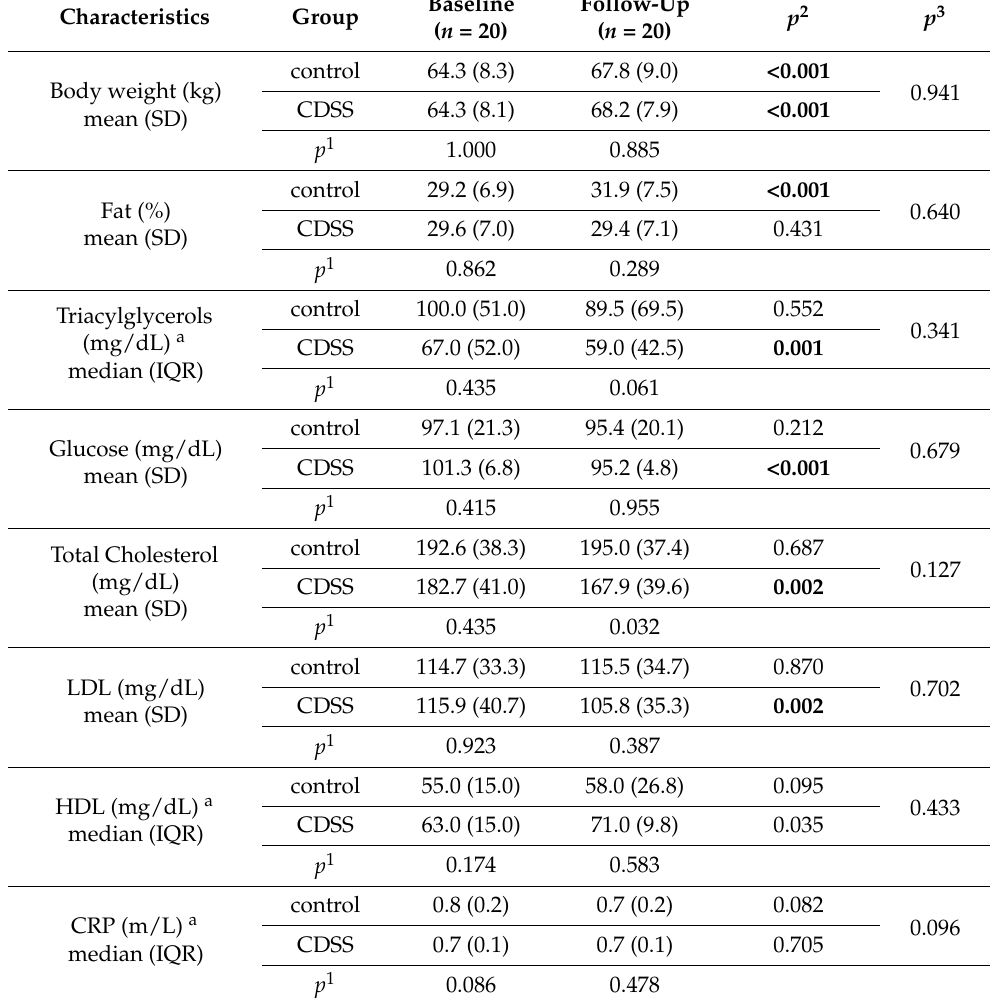
Table 3. Anthropometric characteristics and blood markers at baseline and